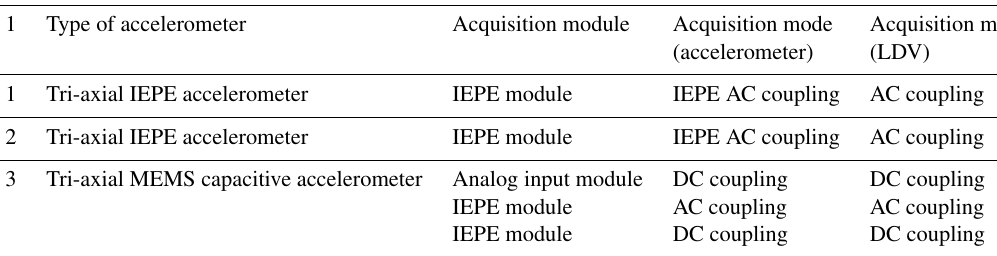
Table 1. Accelerometers being tested and their measuring chains.